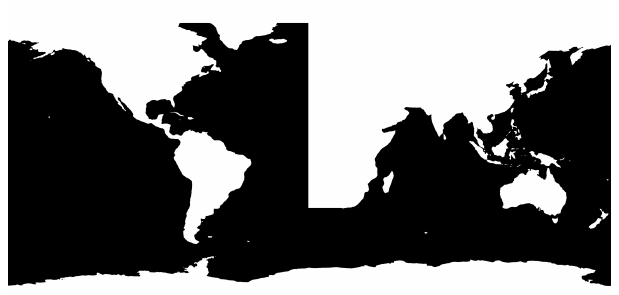
Figure 3. Idealized, binary geometry mask for the Kelvin wave